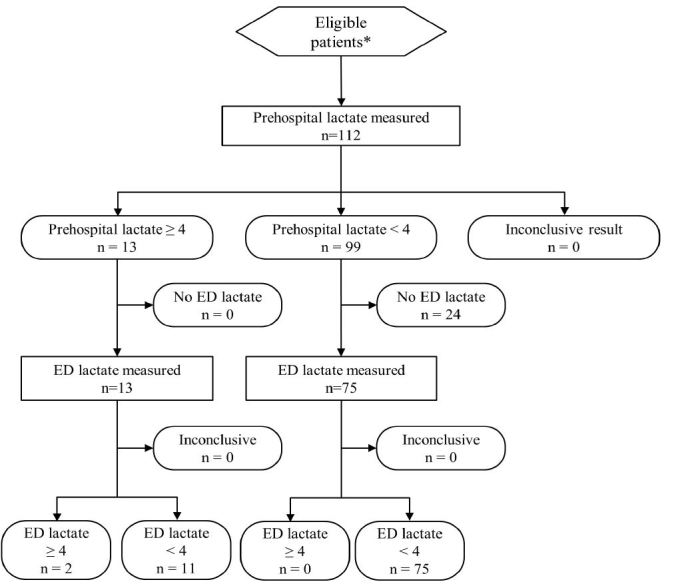
Flow diagram of patient prehospital and emergency department (ED) lactate measurements.